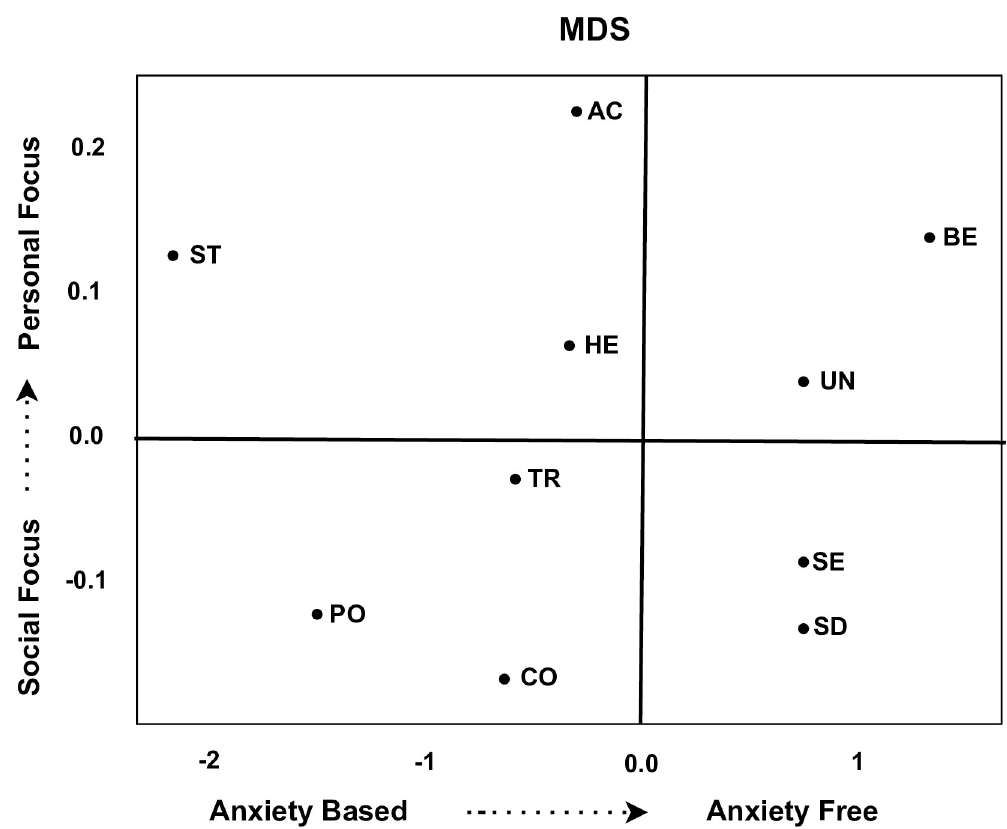
Fig 4. Dynamic relationship between values for cluster C 12